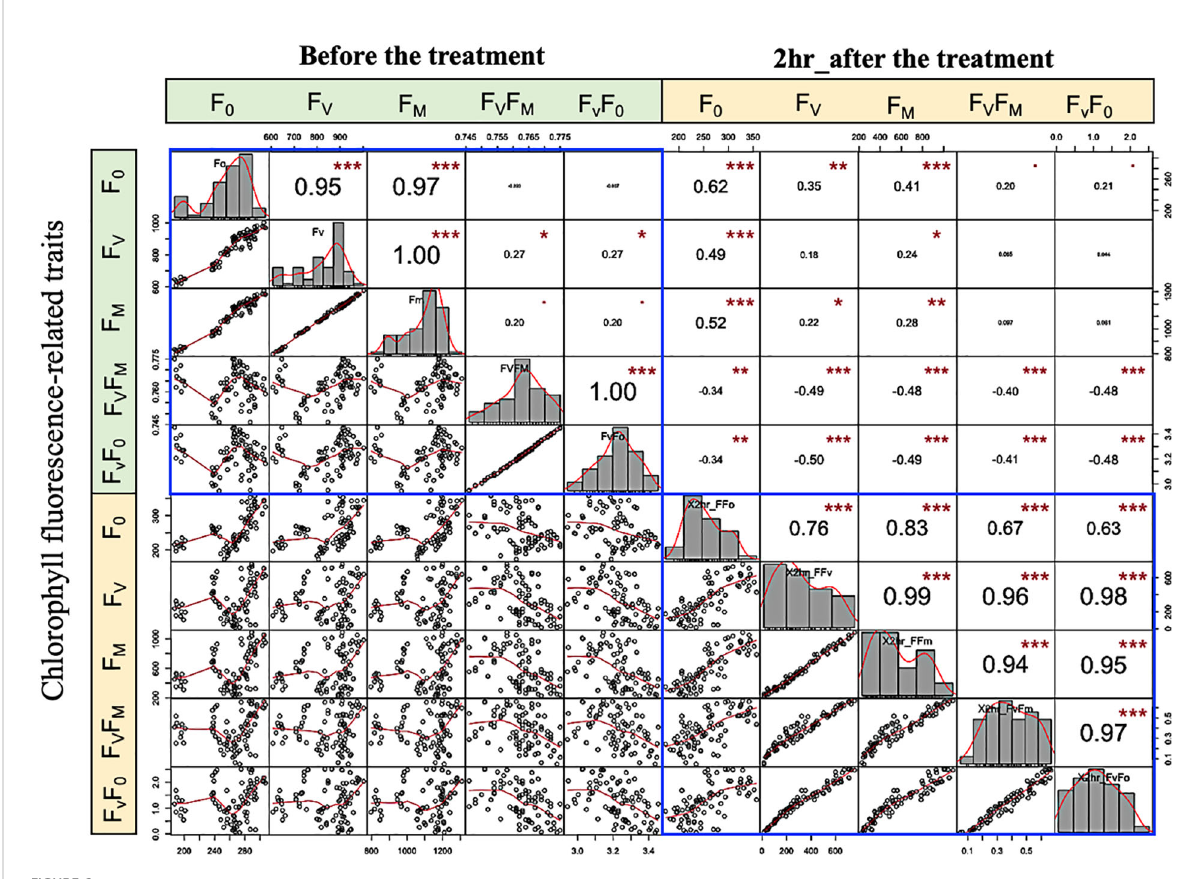
FIGURE 6 Variation and spearman scatter plots correlations among low-temperature-related traits. Histograms for F 0, F V , F M , F V /F M, and F V /F 0 values measured are displayed along the diagonal. The distribution of each variable is shown on the diagonal. On the bottom of the diagonal: the bivariate scatter plots with a fi tted line are displayed. On the top of the diagonal: the value of the correlation plus the signi fi cance level as stars “ . “ , *,**, and *** are signi fi cance level P value 0.001, 0.01, 0.05, 0.1, 1 (not-signi fi cant, signi fi cant, very signi fi cant, and extremely signi fi cant,